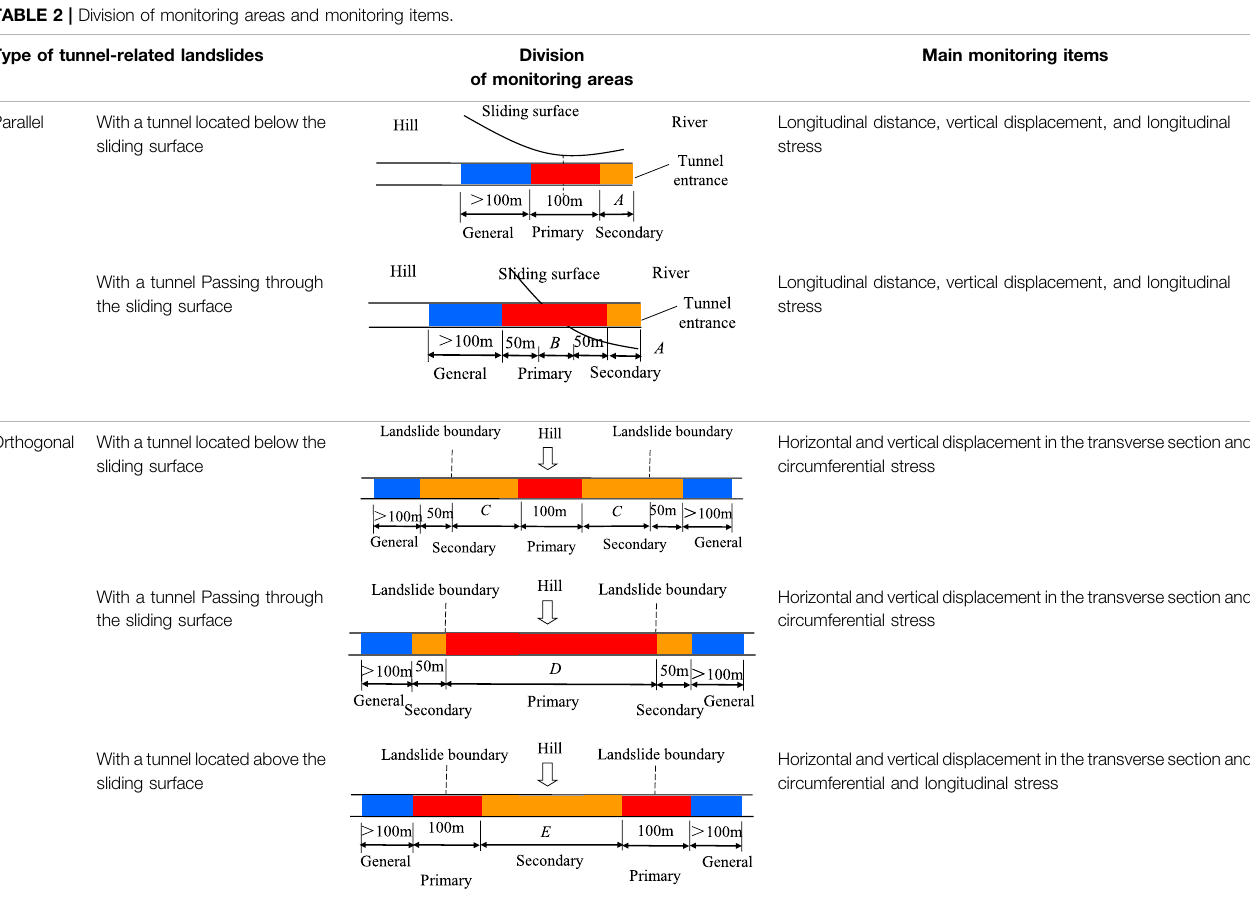
TABLE 2 | Division of monitoring areas and monitoring items.